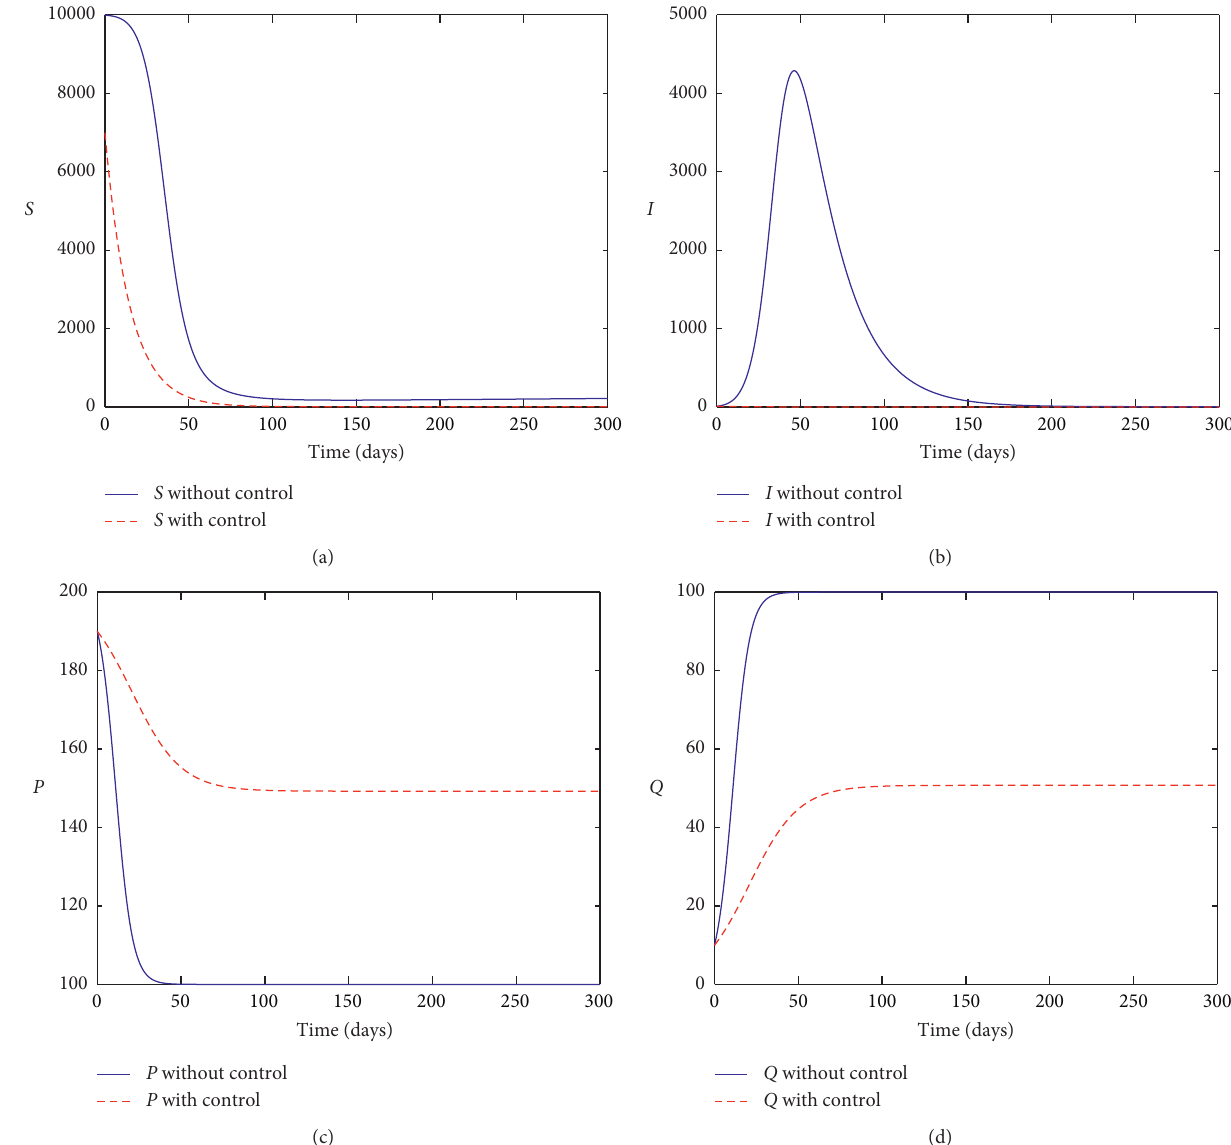
Figure 3: Graphical illustration of possible dynamics of model (1) and multiple control model